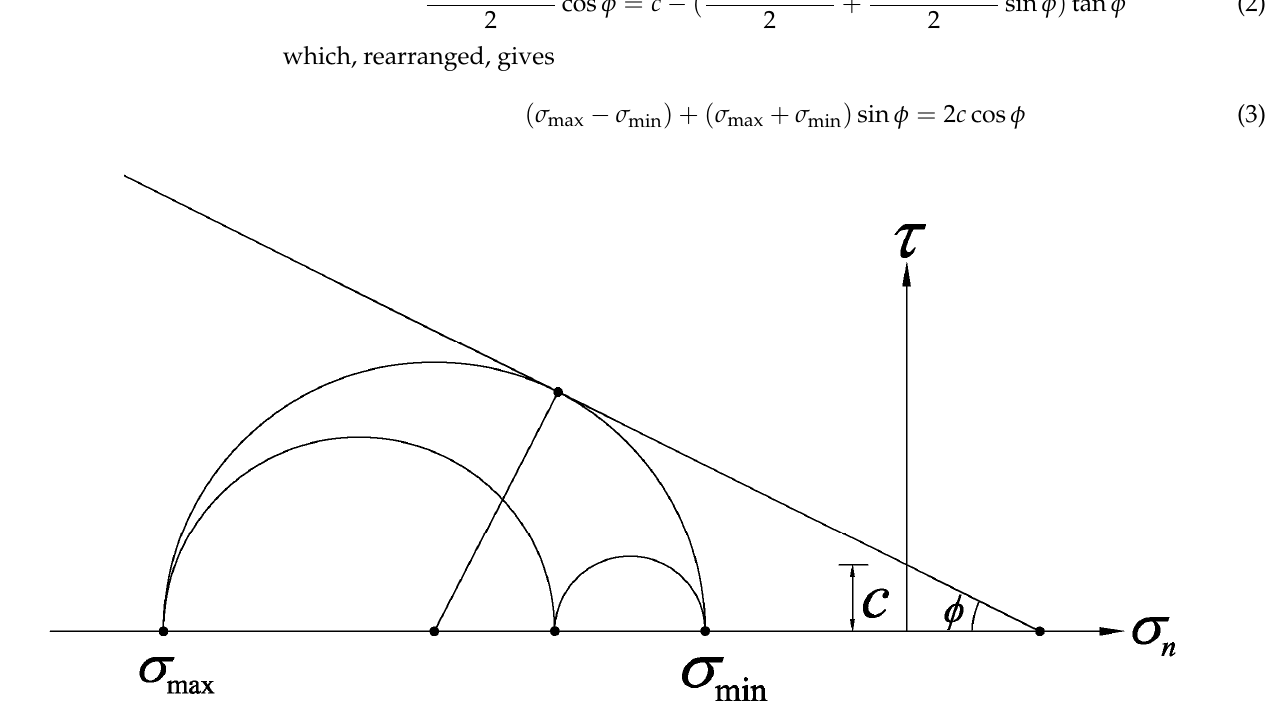
Figure 1. The Mohr-Coulomb criterion.